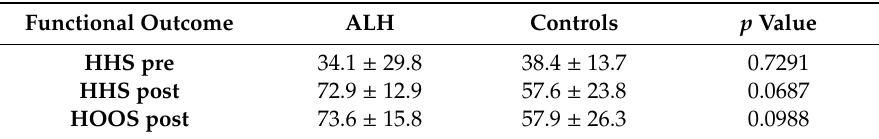
Table 5. Pre and postoperative functional